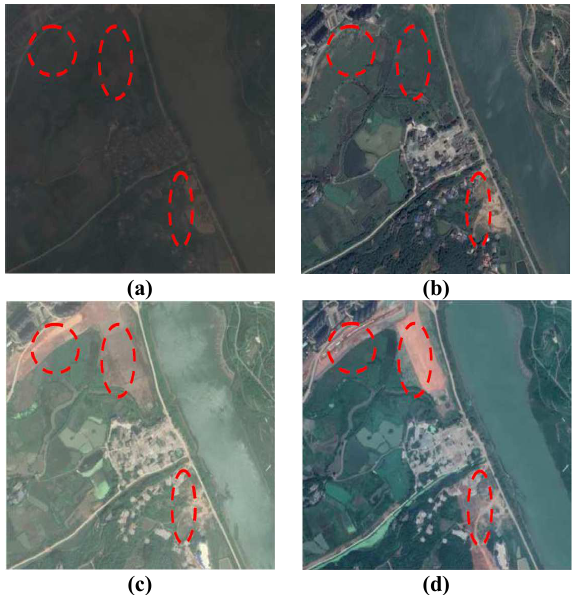
Table 1. Comparative analysis of different methods on the dataset 1 Figure 3. Experimental images with different imaging conditions, e.g., different light conditions, clouds. Methods In Table 2, the metric results of Experimental images (Figure 3a-3d) obtained by the geometrical mapping entropy model and traditional image entropy are listed. Table 2. Comparative analysis of different methods on the dataset